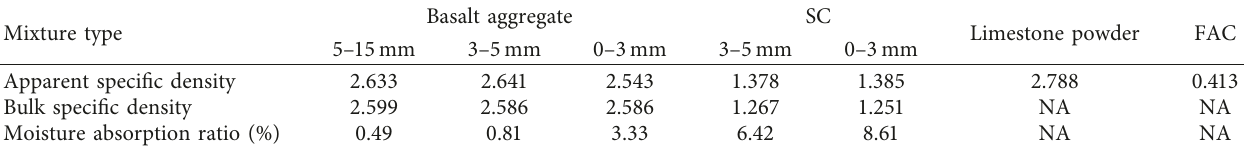
Table 3: Physical properties of aggregates and